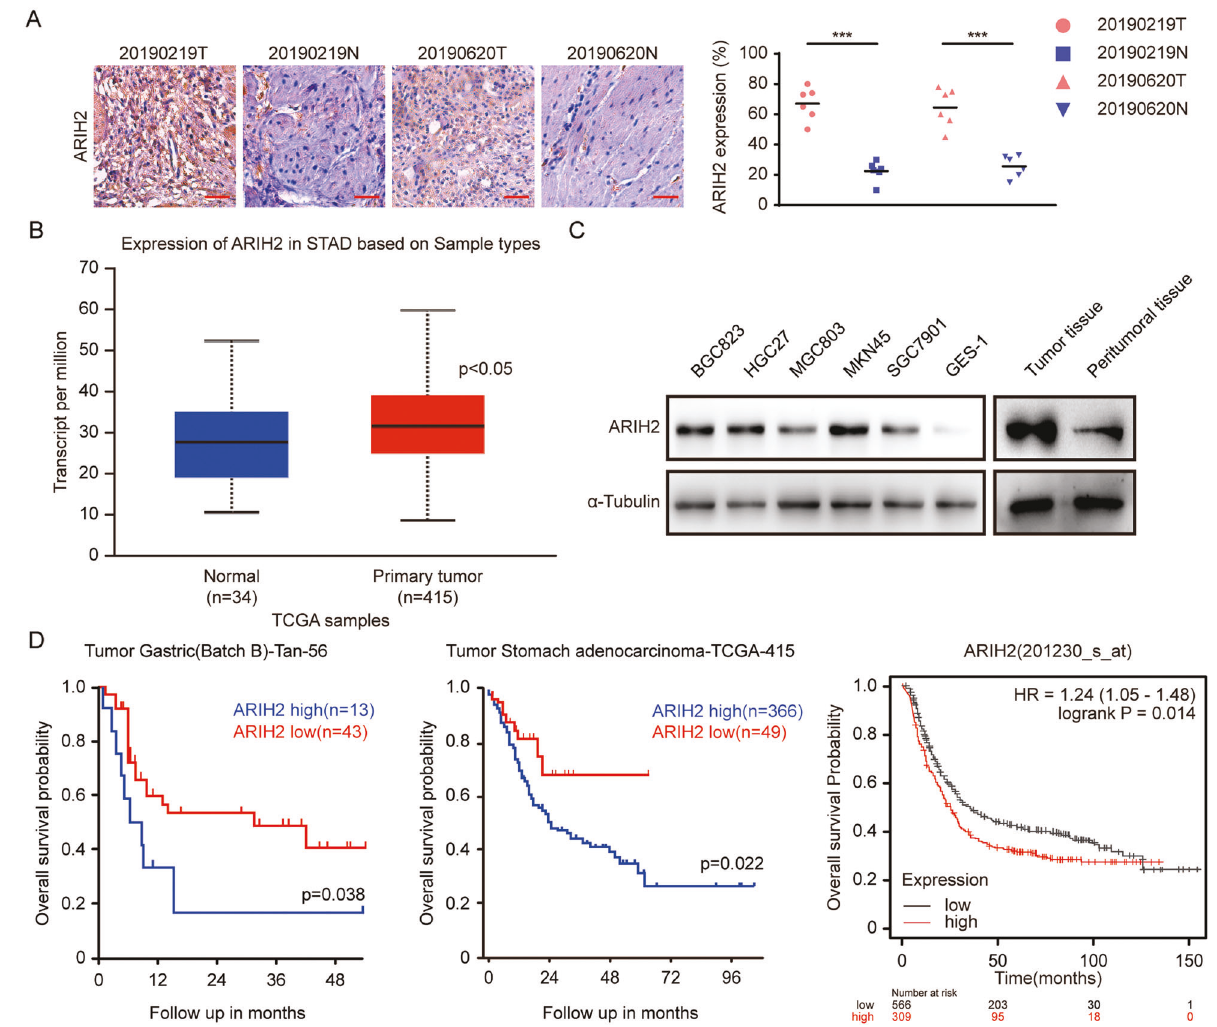
Fig. 1 High ARIH2 expression is correlated with poor GC patient prognosis. A Immunohistochemical staining analysis showed the expression of ARIH2 and quanti fi ed the expression of ARIH2 in normal and GC tumor tissues. Scale bar = 50 μ m. B Box plot of ARIH2 expression levels in the peritumoral tissues (normal) and GC tumors with log-rank test P values < 0.05. C Western blot assays were used to detect the protein expression of ARIH2 in GC tissues and peritumoral tissues (normal), as well as in the normal gastric cell line (GES-1) and GC cell lines (BGC823, HGC27, MGC803, MKN45, SGC7901). D Kaplan – Meier analysis of progression-free survival using data from three different GC databases. All data are expressed as the mean ± SD. Student ’ s t test was performed to analyze signi fi cance. * P < 0.05, ** P < 0.01, *** P <